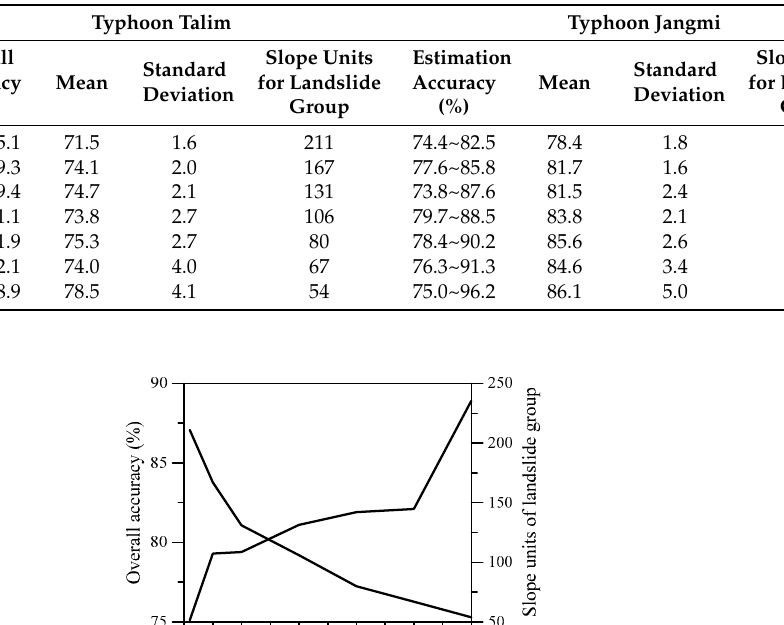
Table 2. List of the thresholds and the statistics of corresponding estimation accuracy.